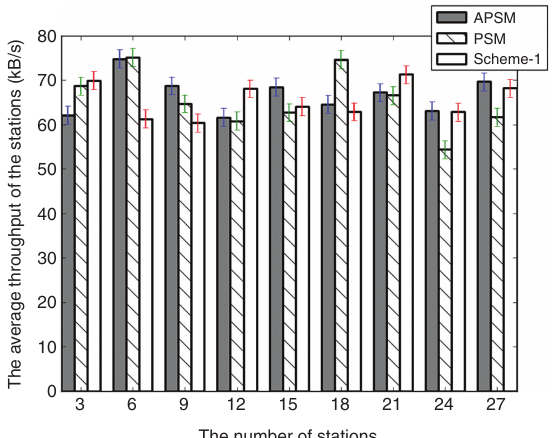
Figure 6. Comparison of Throughput, c Increases When ρ = 0.3, PAR